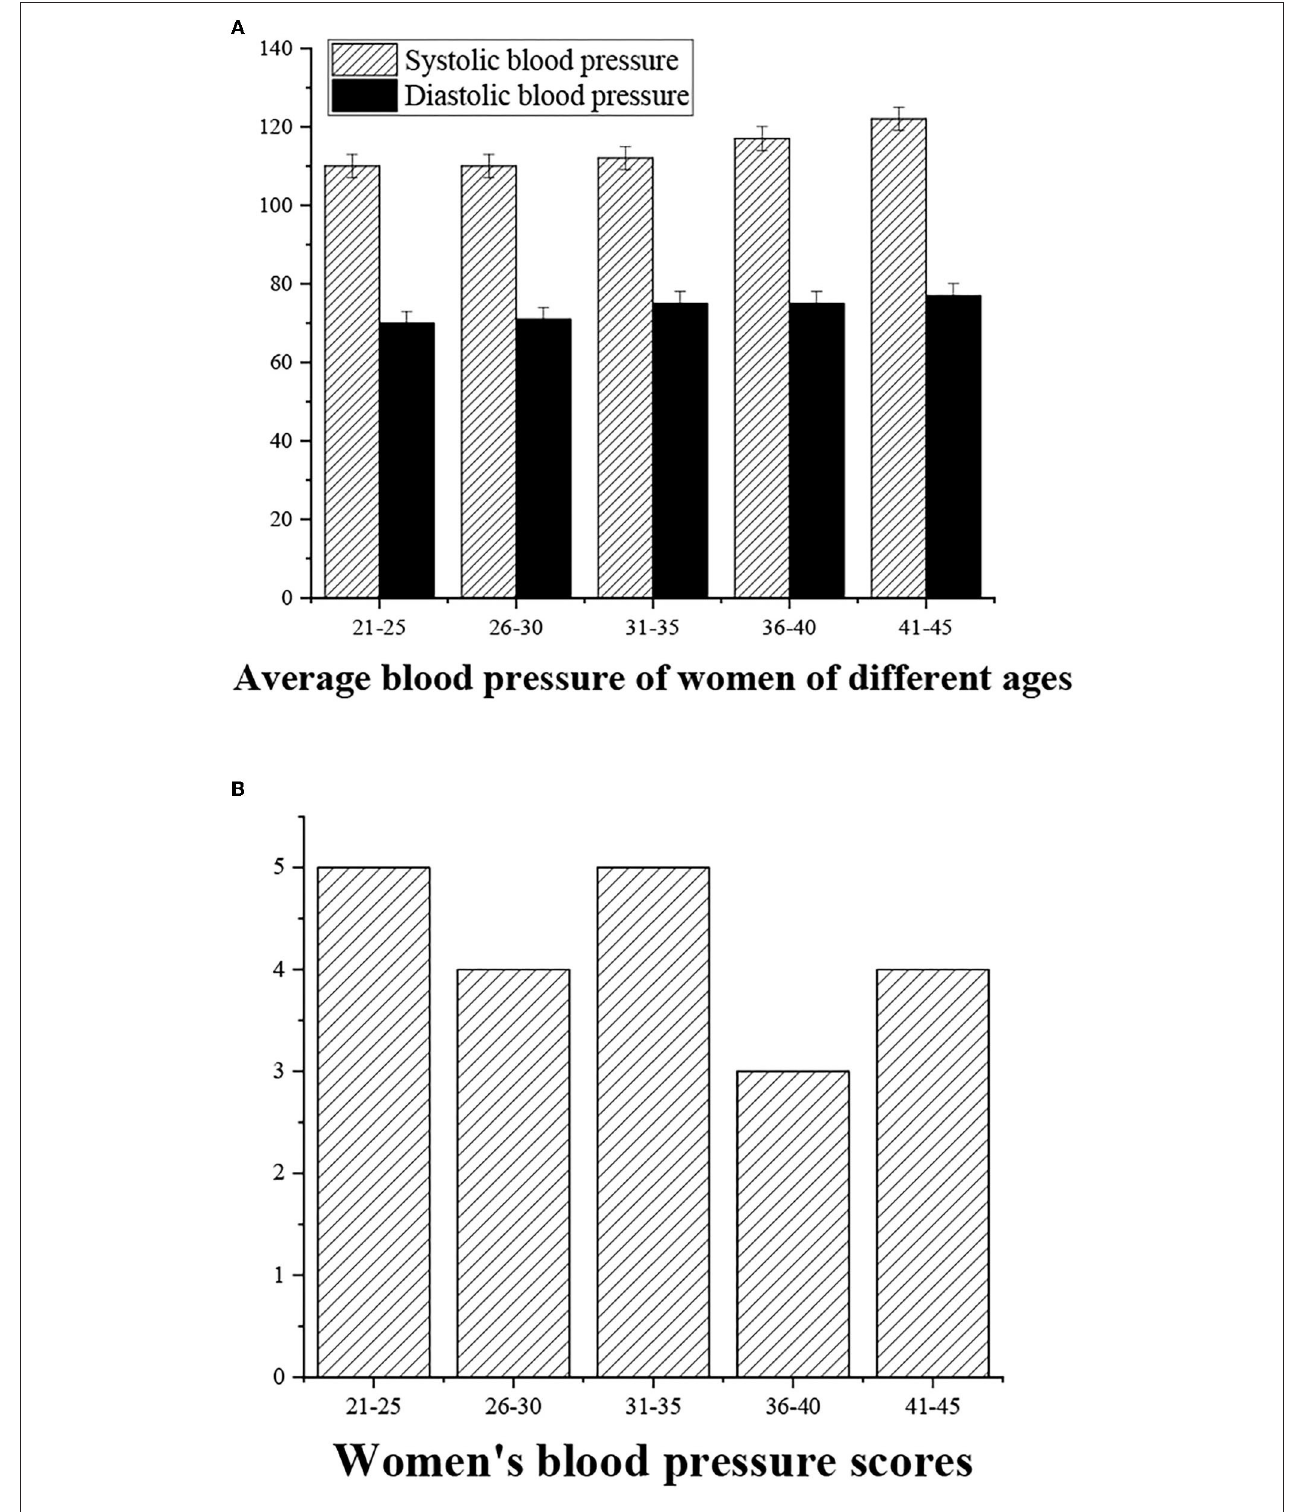
FIGURE 5 | (A) Statistical average blood pressure (SBP/DBP) for women of different ages. (B) Blood pressure measurement score.